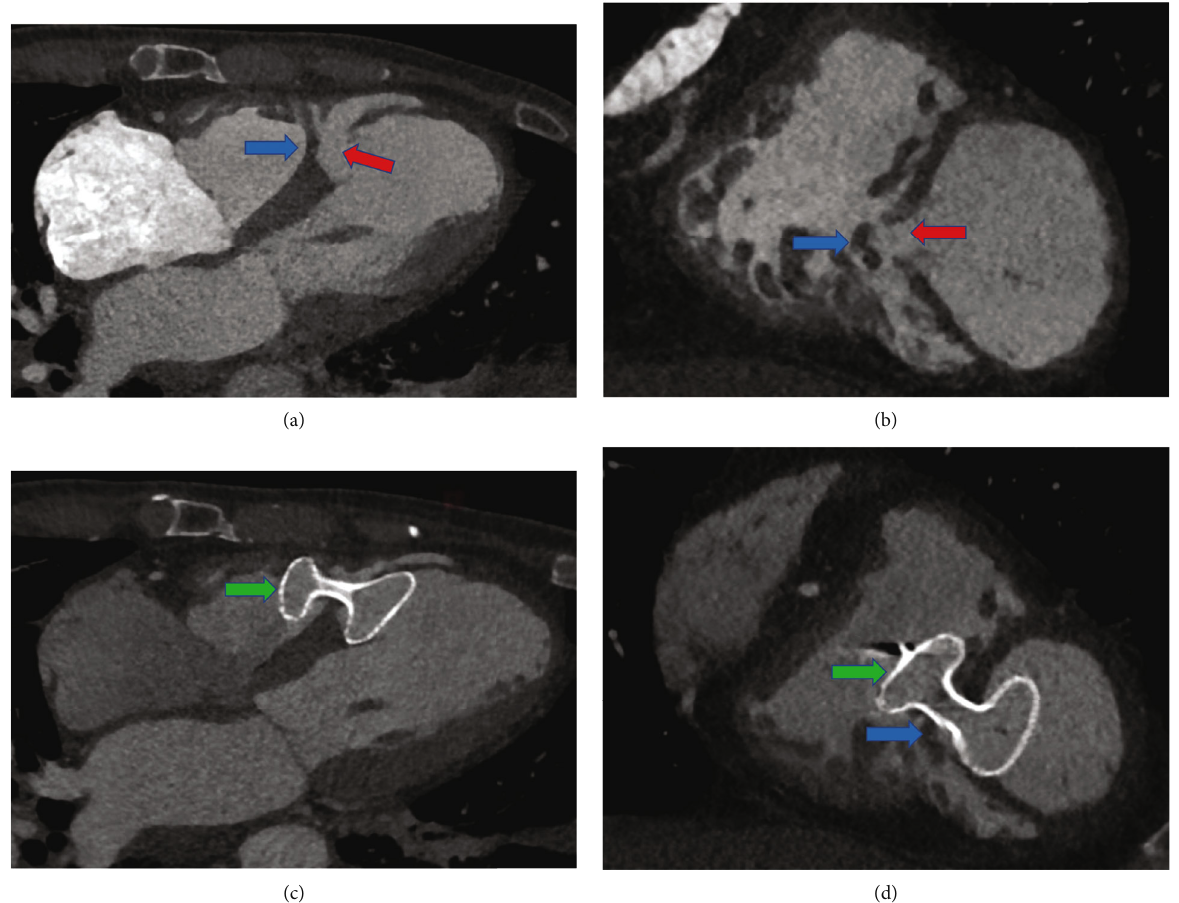
Figure 3: (a) Preoperative horizontal plane imaging by cardiac CTA. (b) preoperative coronal plane imaging by cardiac CTA, showing that the right ventricular surface defect has the moderator band barrier. (c) Postoperative horizontal plane imaging by cardiac CTA. (d) Postoperative coronal plane imaging by cardiac CTA, showing that the occluder waist diameter is severely compressed due to the moderator band barrier. The red arrow in the fi gure indicates the VSR position, the blue arrow indicates the adjustment band, and the green arrow indicates the occluder. Table 5: E ff ect of di ff erent perforation sites and right ventricular surface obstruction on occluder.